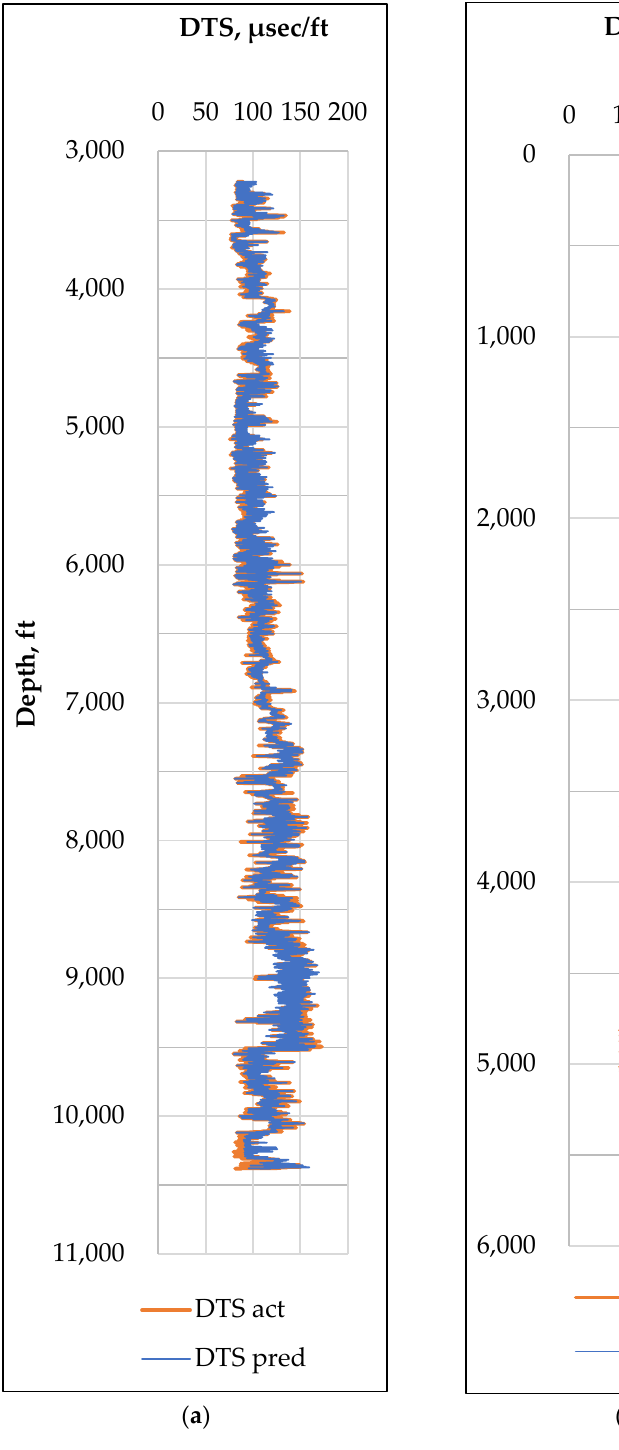
Figure 17. Validation for ( a ) P1 well, ( b ) P2 well ( c ) P3 well.